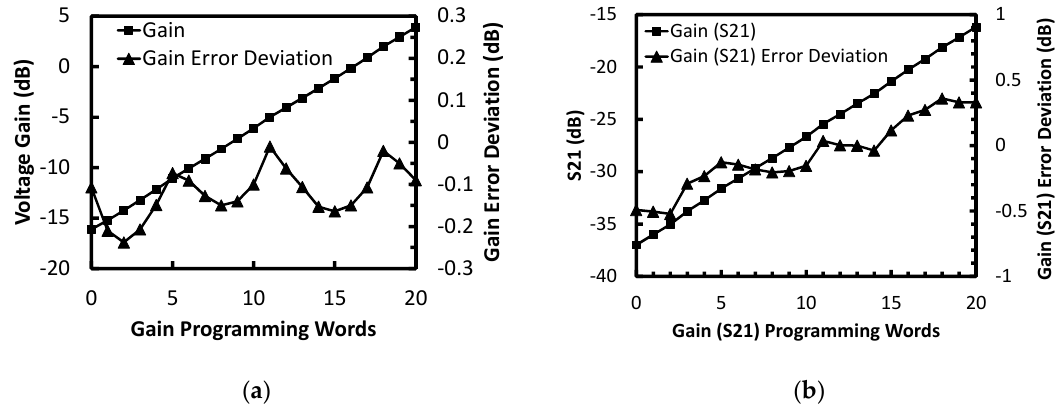
Figure 8. ( a ) Simulated voltage gain and gain error deviation of the PGA. ( b ) Simulated S 21 and gain error deviation of the PGA.